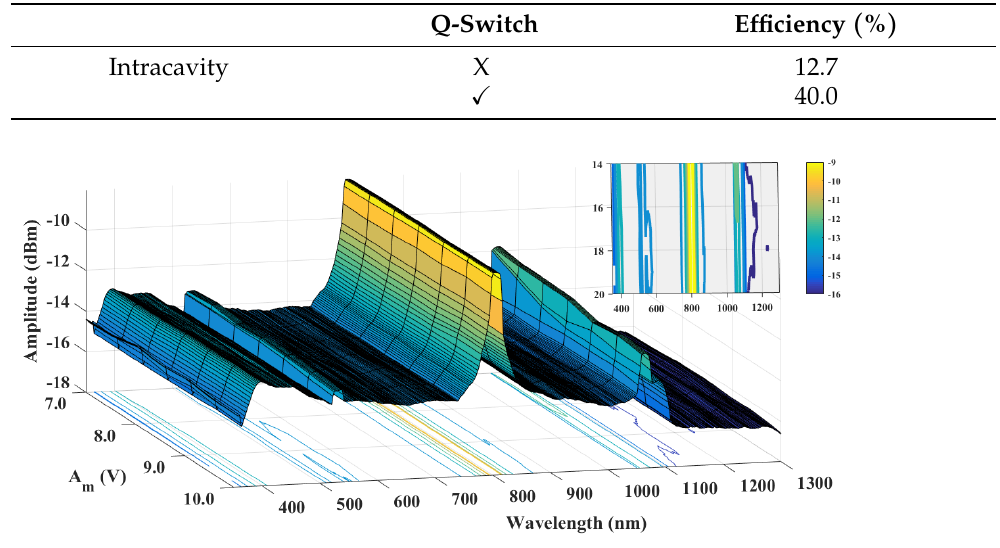
Table 1. Optical efficiency conversion with intra-cavity configuration without modulation at V = 7 V and I = 2.1 A.